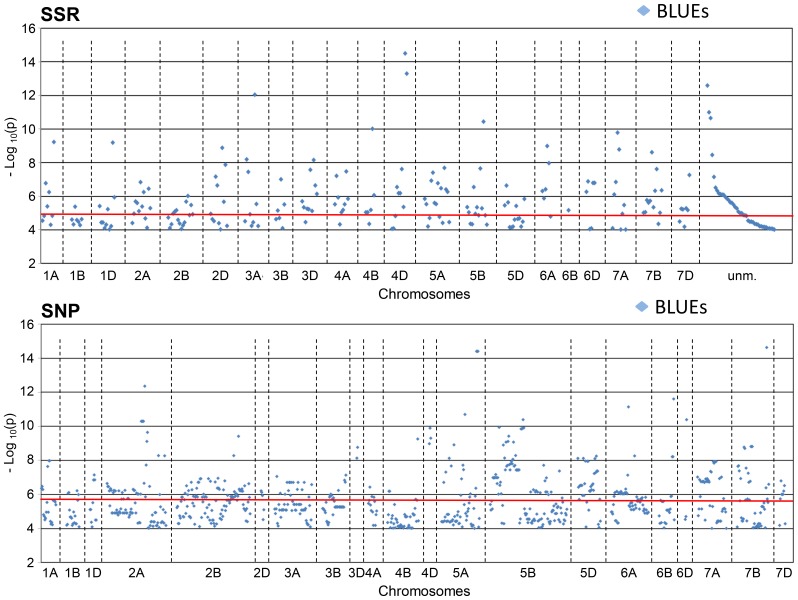
Manhattan plots of SSR or SNP marker alleles associated with plant height.The plot presents significant MTAs at a threshold of –log10 (P-value) ≥4.0 for BLUEs sorted according to their chromosomal location. The red line indicates the threshold for Bonferroni correction, –log10 (P-value) ≥4.82 (SSR) and ≥5.89 (SNP).